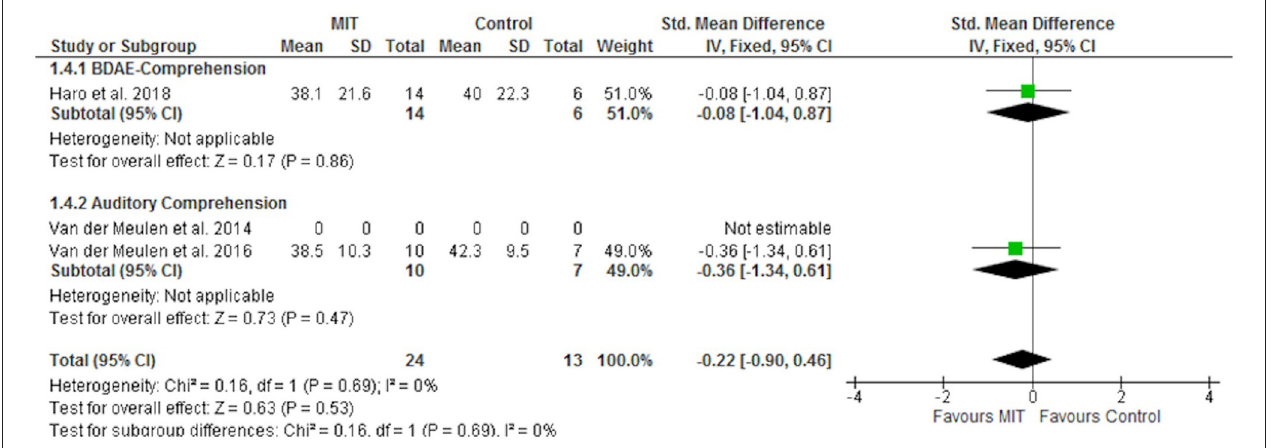
FIGURE 4 | Forest plot of the effect of MIT on